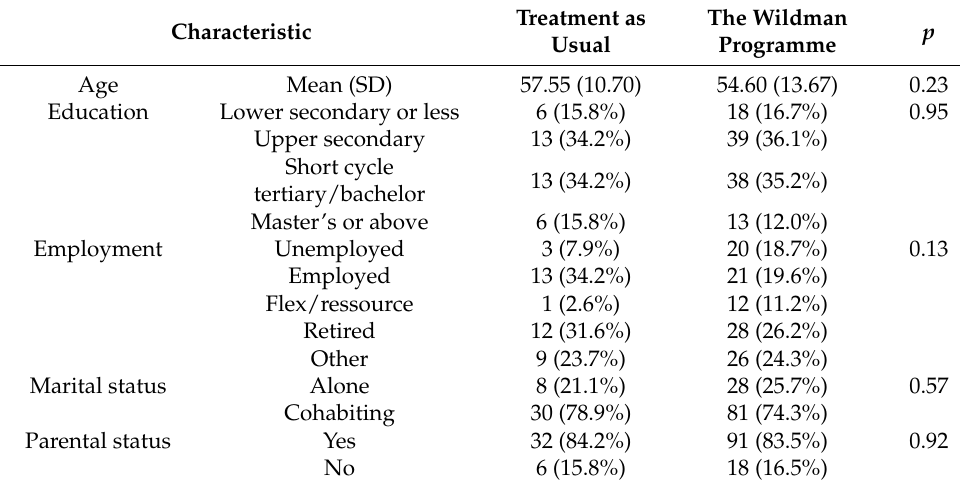
Table 1. Baseline demographics and characteristics of the